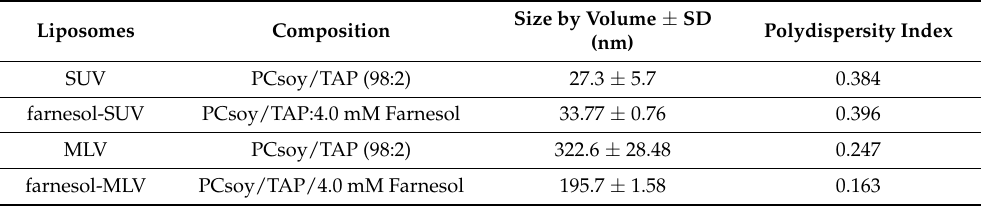
Figure 1 . Preparation of control and farnesol vesicles. ( a ) The molecular structure of DOTAP, PC/soy, and farnesol are presented; ( b ) Chromatograms represent one of three independent HPLC analyses of free farnesol (4 mM, upper panel), farnesol-SUV (4 mM, middle panel), and farnesol-MLV (4 mM, lower panel) are presented. Mean liposomal encapsulation efficiencies (LEE) ±SD were calculated from three independent runs and indicated at the top-right of each chromatograph. High resolution images were provided in Supplementary Materials, Figure S2. Table 1. Physicochemical characterization of liposomes evaluated by DLS.